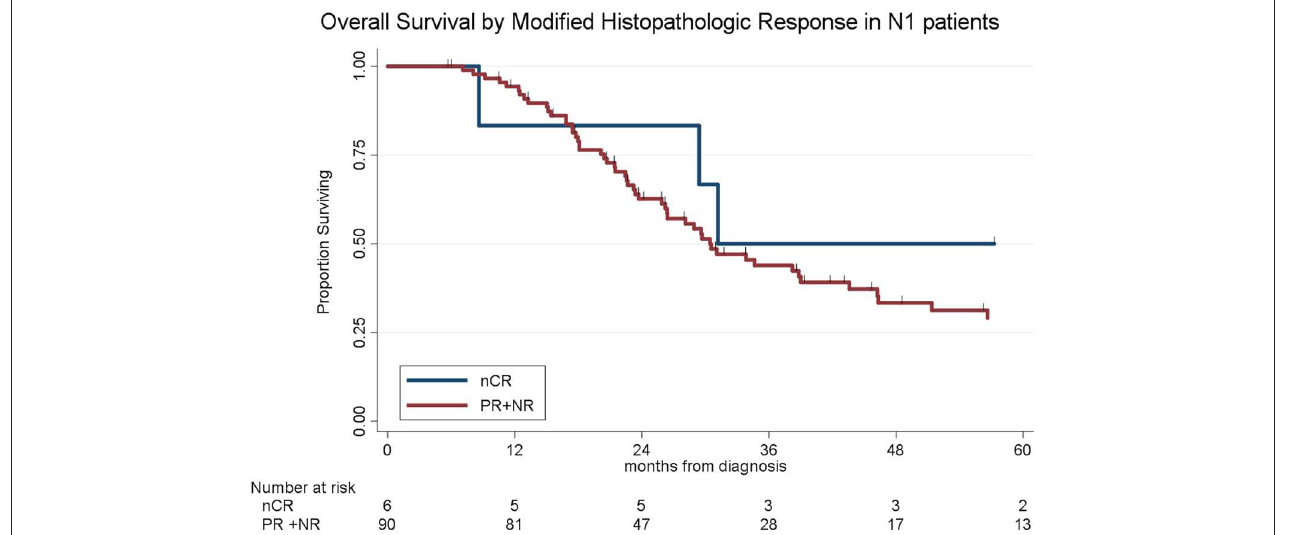
FIGURE 5 | Overall survival by modified histopathologic response among N1 patients.